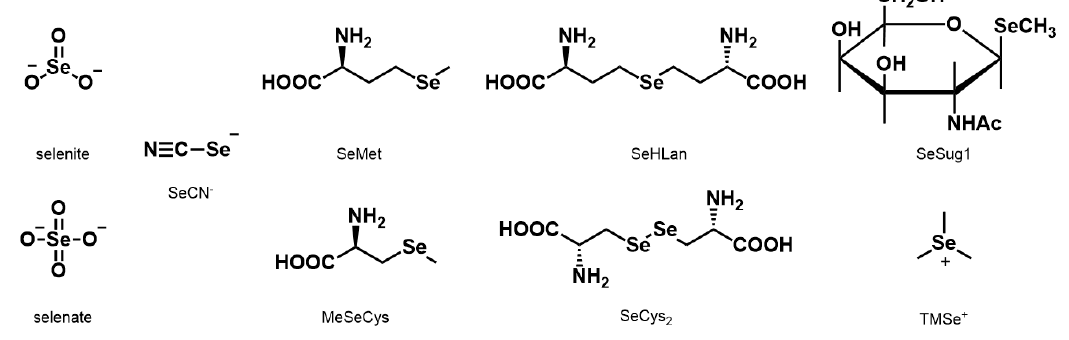
Figure 1. Structures of bioselenocompounds used in this study. SeCN − : selenocyanate, SeMet: L